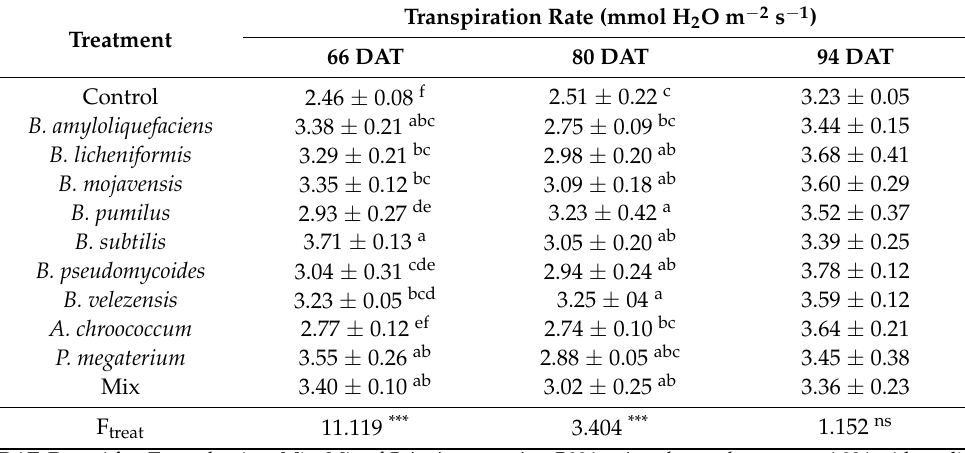
Table 5. Effect of PGPB strains on transpiration rate 66, 80, and 94 DAT.